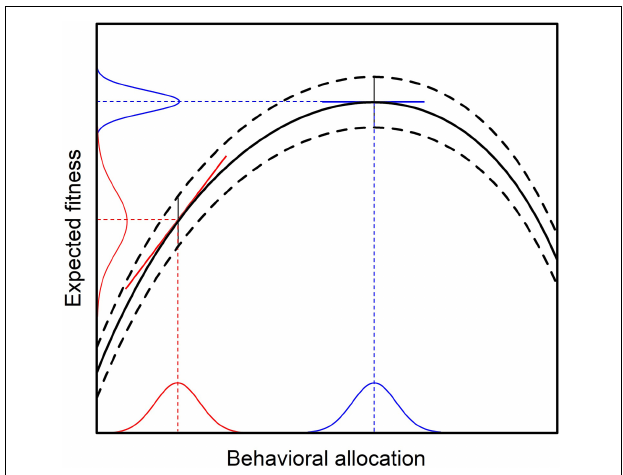
FIGURE 3 | Relation between average behavior and variance in expected evolutionary fitness as implied by the MLBS. Given constant error variance (indicated by the curved dashed lines), the variance of the expected fitness consequences conditioned on average behavior depends on behavioral variance and the slope of the fitness function (i.e., marginal reinforcer value). Consequently, the variance of expected fitness will be higher than the error variance when the slope of the fitness function has a high absolute value (red lines). The covariance based law of effect predicts that behavioral change is proportional to marginal reinforcer value. Hence, when the slope of the fitness function is zero (blue lines), there will be no change in average behavior. This coincides with the point where the variance in expected fitness is smallest, resulting in maximum Fisher information about the expected fitness consequences conditioned on average